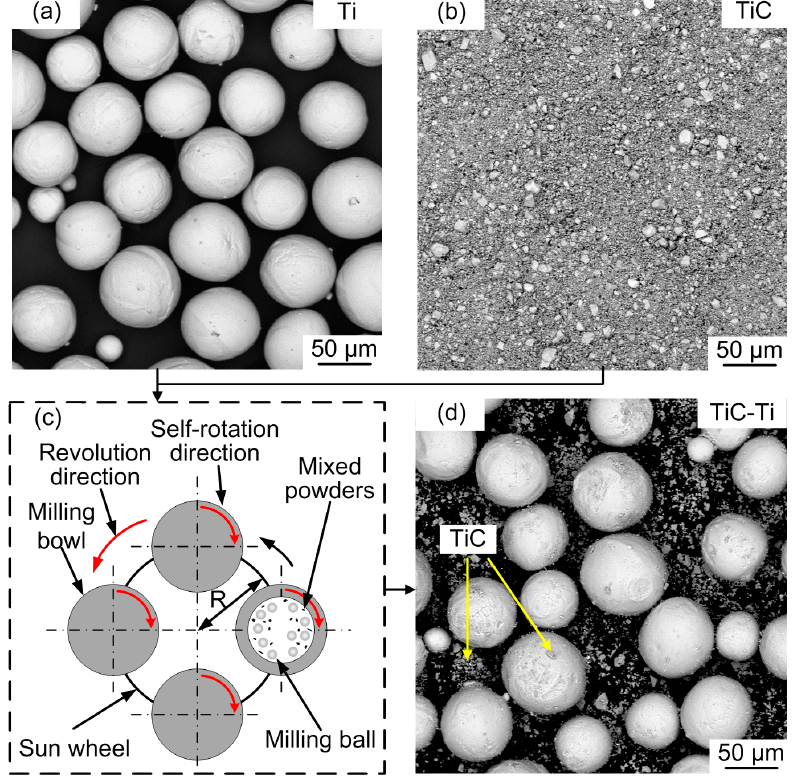
Figure 1. Powder pretreatment: ( a ) Ti powder; ( b ) TiC powder; ( c ) planetary ball milling process; ( d ) prepared TiC-Ti powder.